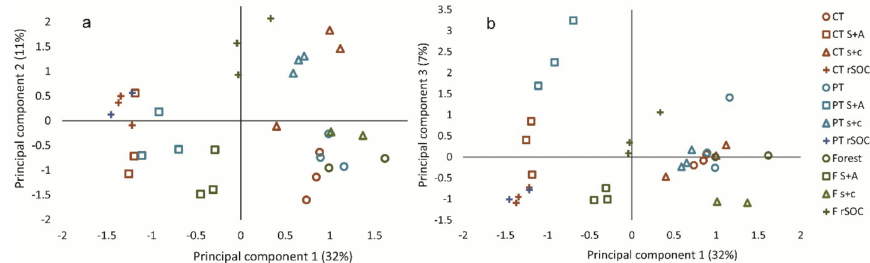
Figure 3. Data distribution along principal components 1 and 2 ( a ) and 1 and 3 ( b ). CT: